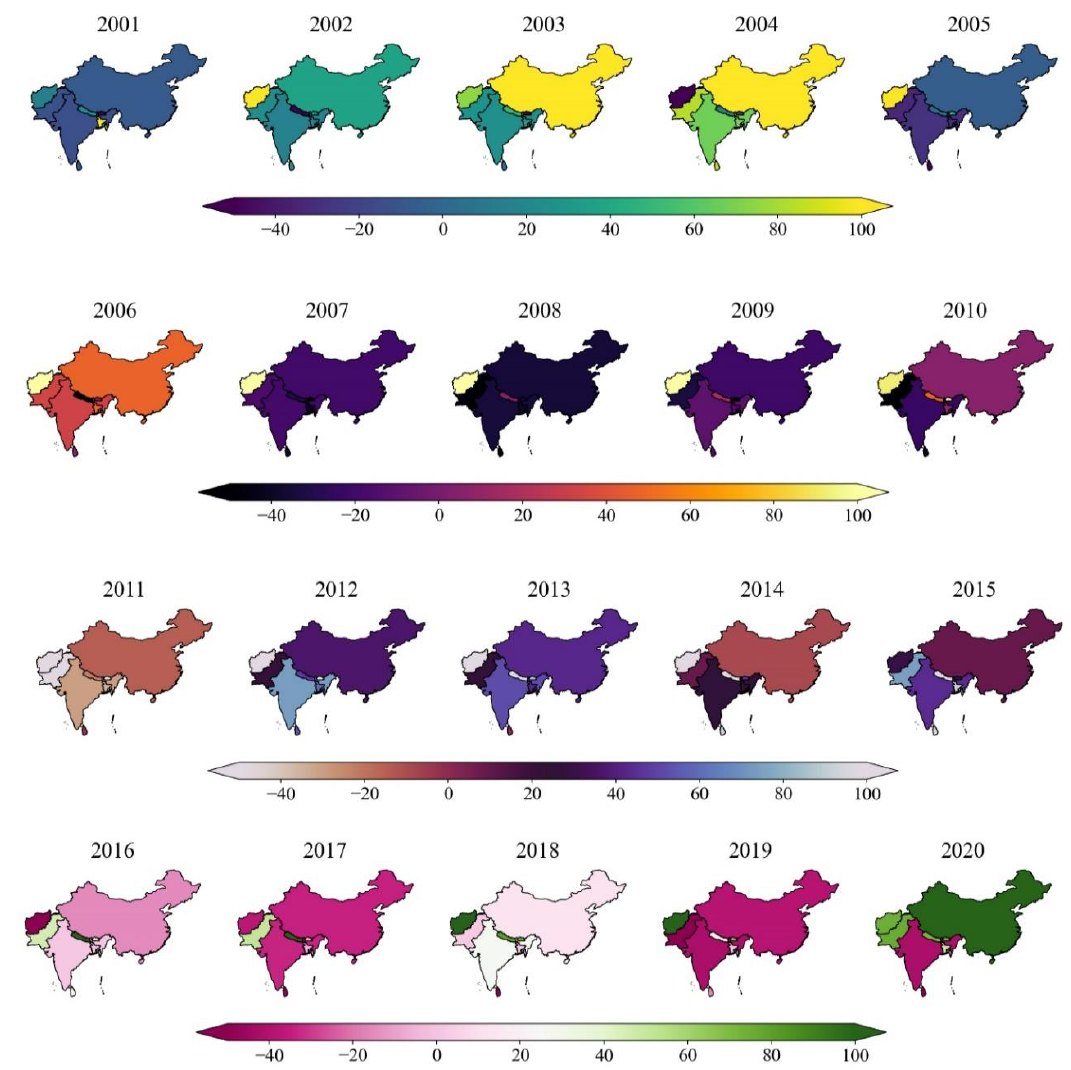
Figure 6. Carbon emissions in the last 20 years in China and South Asian countries.